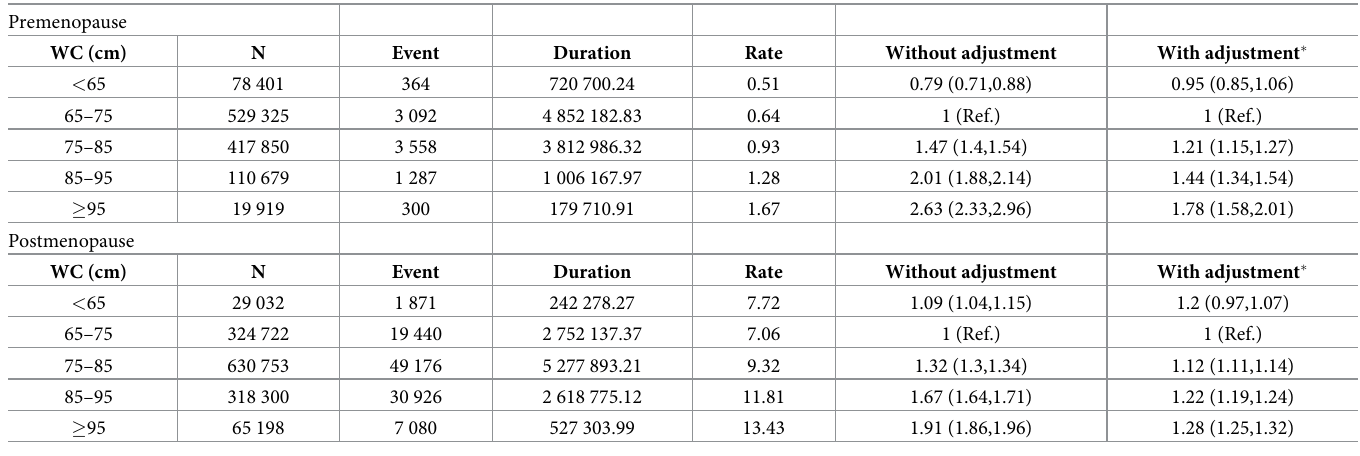
Table 6. Cox proportional hazards regression analysis for the development of vertebral fracture according to WC in the premenopausal and the postmenopausal groups.